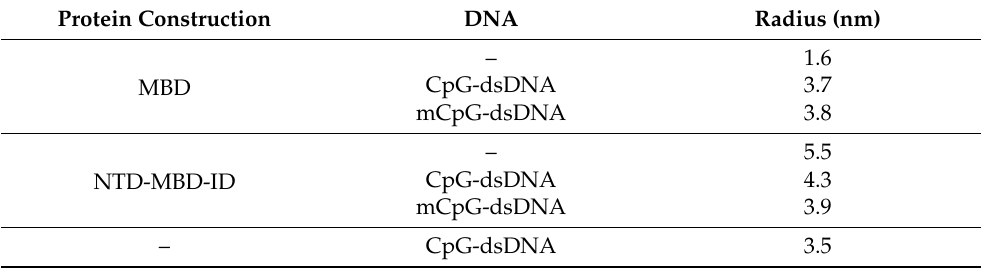
Table 6 . Hydrodynamic radius of the two protein constructs in complex with dsDNA estimated by dynamic light scattering.